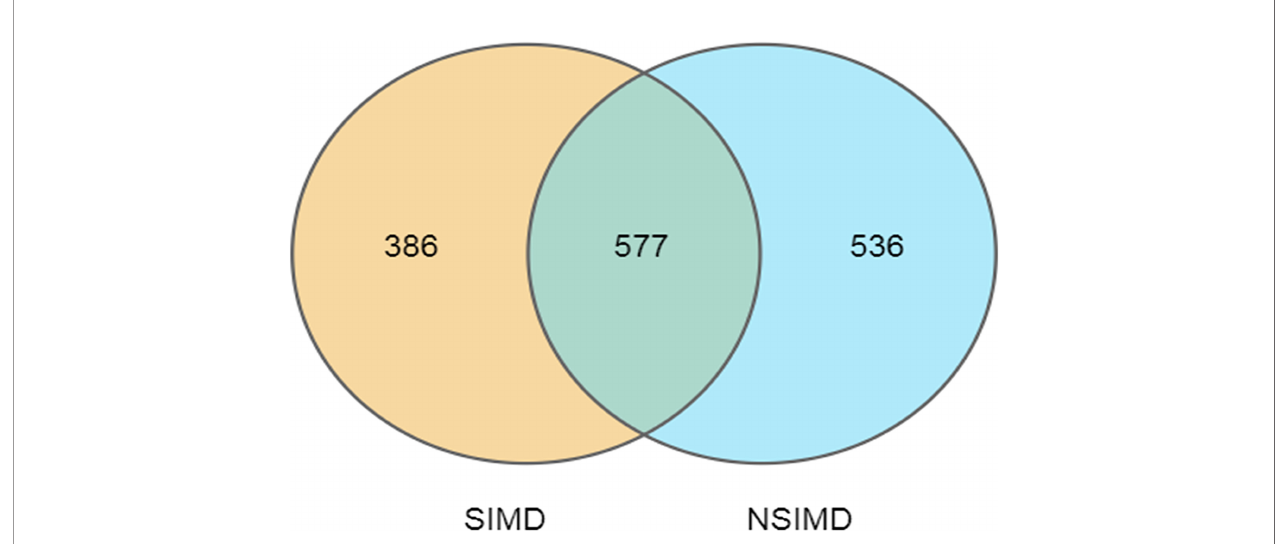
FIGURE 2 | Venn diagram of the unique and shared OTUs between two groups. Fecal microbiota richness was signi fi cantly decreased in the SIMD group. OTUs, operational taxonomic units; SIMD, sepsis-induced myocardial